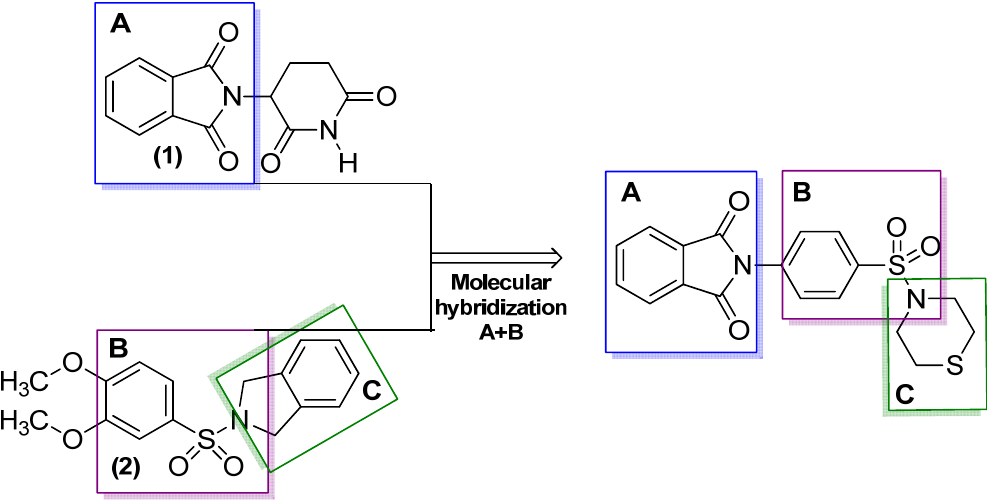
Figure 4. Hybrid of TNF α and phosphodiesterase–inhibiting compound with anti-asthma activity [20].